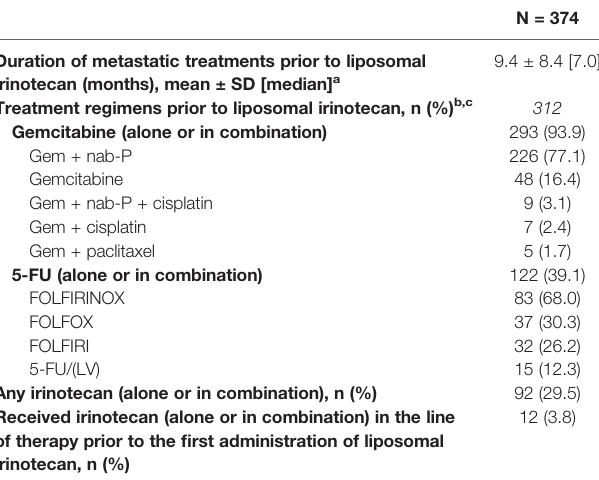
TABLE 3 | Liposomal irinotecan treatment characteristics in the metastatic setting. N =